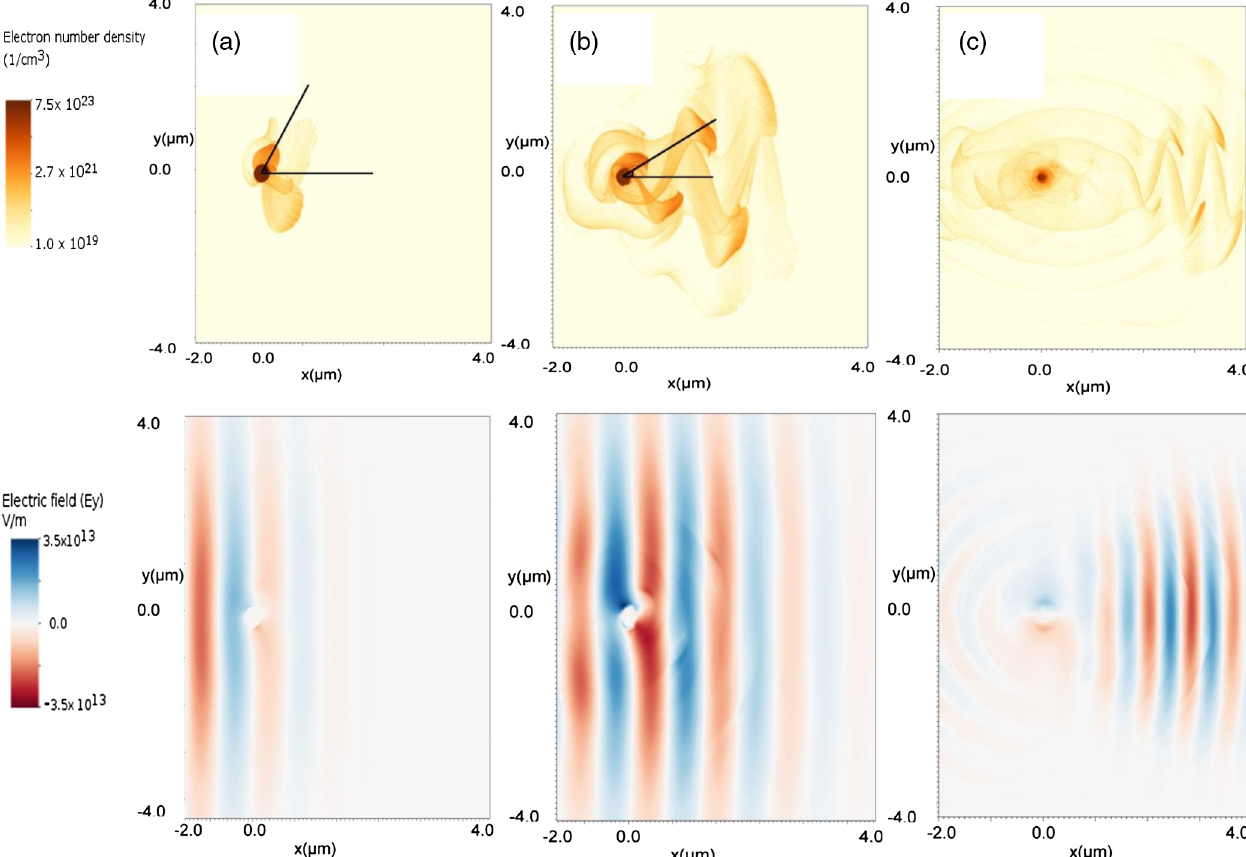
FIG. 1. Laser electric field (bottom, in V = m), and electron number density (top, in m − 3 ) plot for a 100 nm radius droplet hit by a laser pulse of intensity I ¼ 10 20 W = cm 2 at times ≈ 3 fs (a), 8 fs (b), 16 fs (c). The cluster is centered at position (0,0). Angles are measured relative to the center of the most dense region of the bunch. The logarithmic density scale is normalized to the critical density n ¼ 1 . 8 × 10 21 cm − 3 , so that the maximum value corresponds to 100 n c 3 . 5 × 10 13 V =